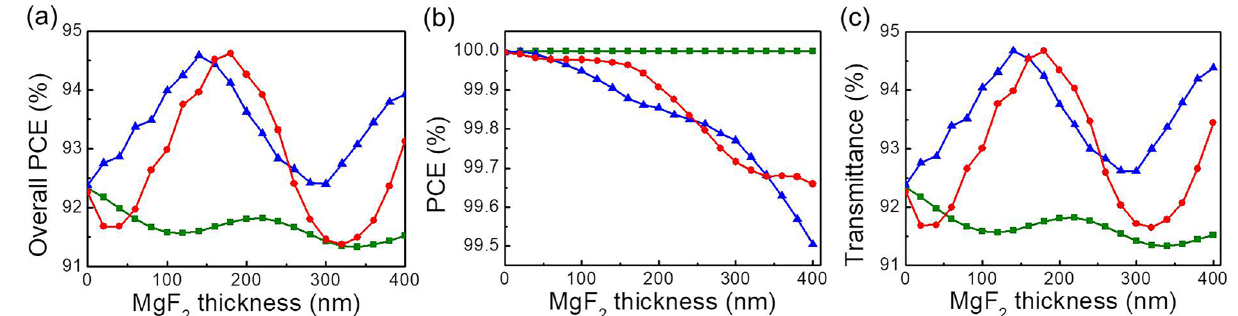
Figure 6. Optical property of Nb 2 O 5 nano-fin consisted with MgF 2 . Simulation results of ( a ) overall PCE, ( b ) PCE, and ( c ) transmittance as a function of MgF 2 thickness. The thickness of Nb 2 O 5 is fixed to be d 3 = 1000 nm. The green square denotes a flat MgF 2 film deposited under the Nb 2 O 5 nano-fin, the red circle denotes a nano-fin located on the top of the MgF 2 nano-structure, and the blue triangle denotes a MgF 2 nano-structure stacked on the top of a